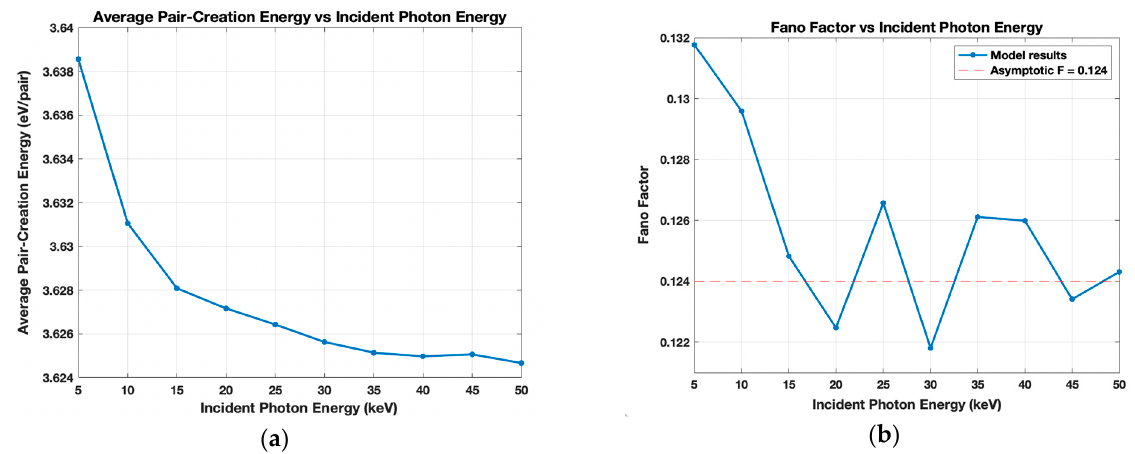
Figure 6. Full model results for 5–50-keV incident photon energy. ( a ) The average pair-creation energy that tends to ~3.63 eV/pair; ( b ) Fano Factor with an asymptotic value 0.124.